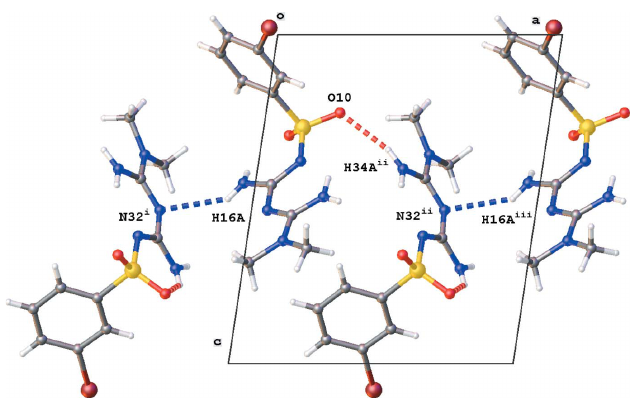
Figure 3 Partial crystal packing of the title compound, showing the chain formation in the a -direction. N—H (cid:2)(cid:2)(cid:2) N and N—H (cid:2)(cid:2)(cid:2) O hydrogen bonding are shown as blue and red dashed lines, respectively. Symmetry